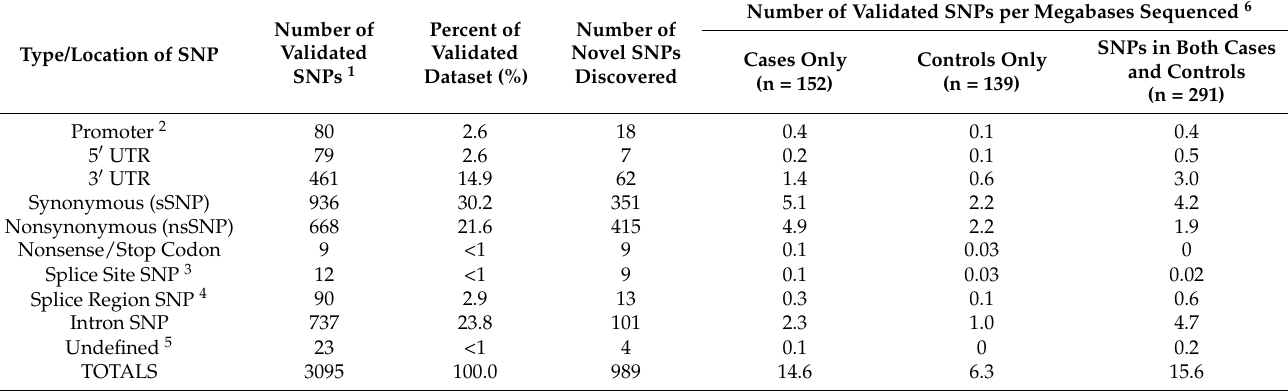
Table 6. SNPs in 237 ion channel genes in subjects having idiopathic generalized epilepsy and neurologically normal